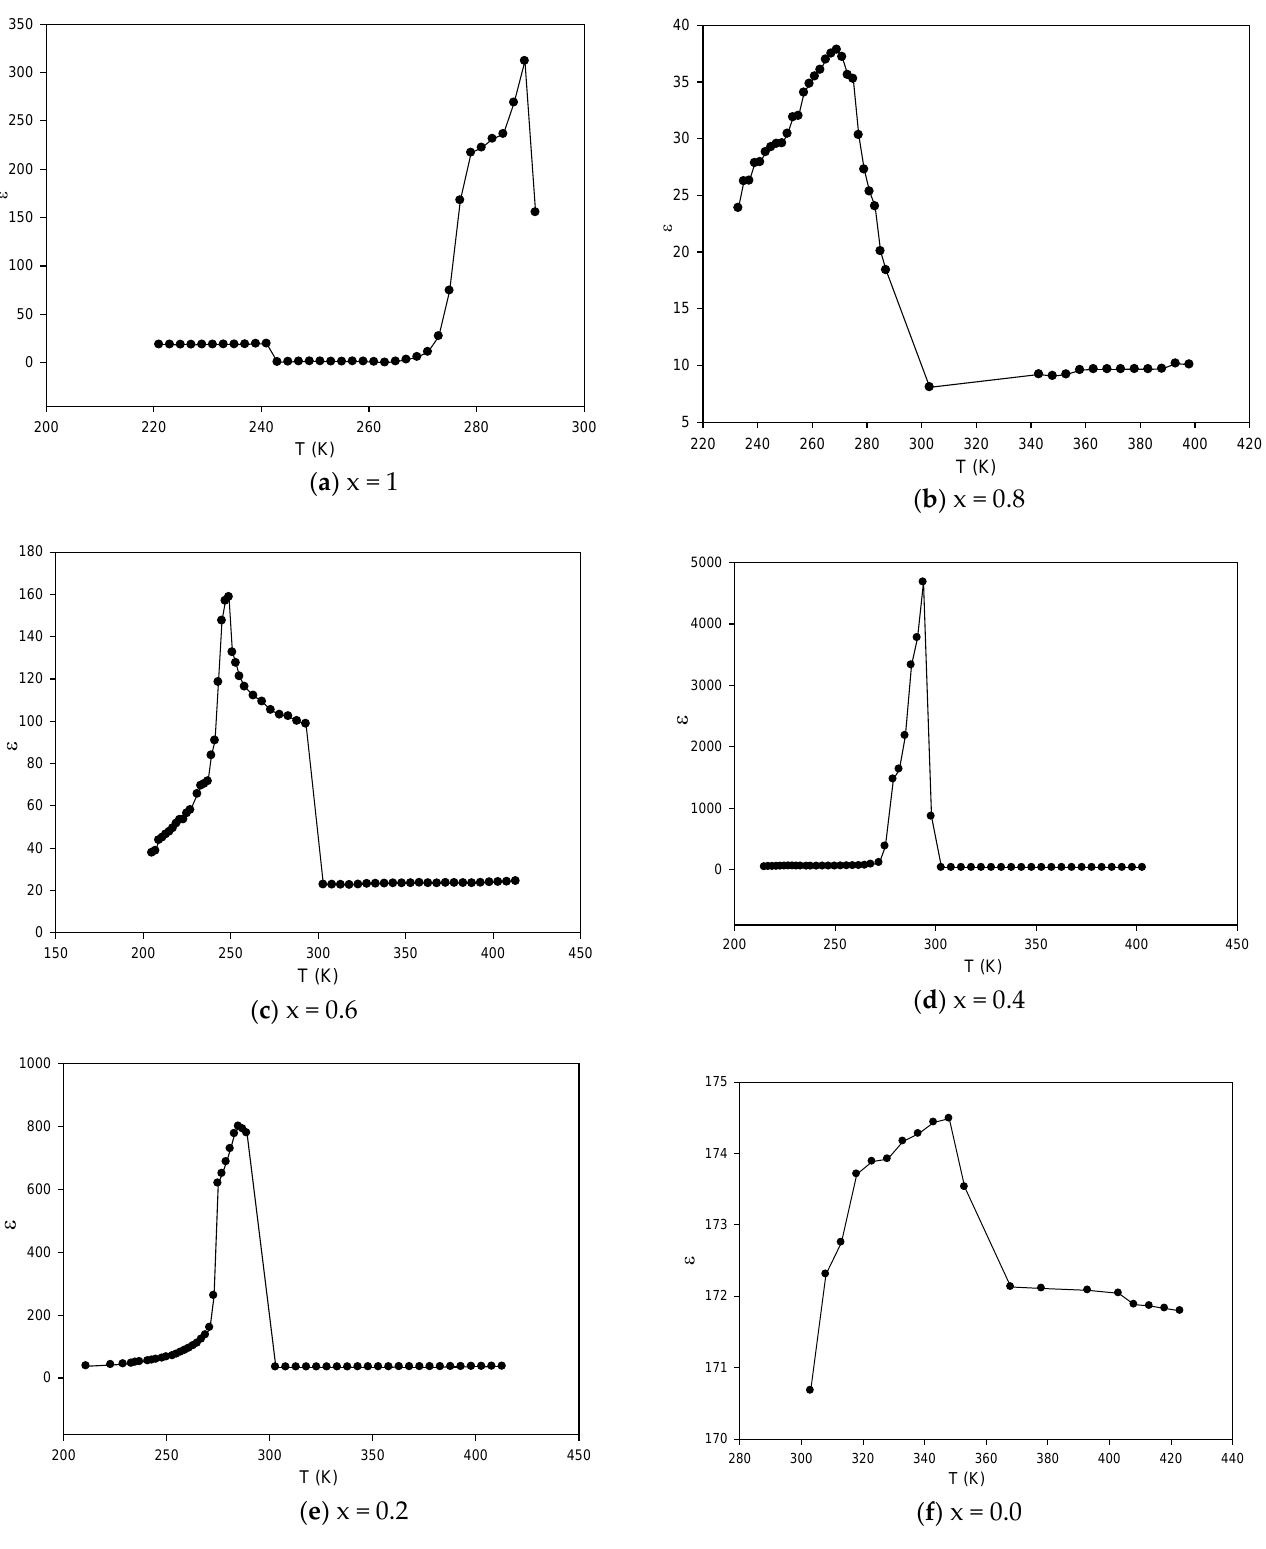
Figure 6. ( a – f ): The effect of temperature on the dielectric constant of (PVDF-BZT) and their composites at 10 kHz.